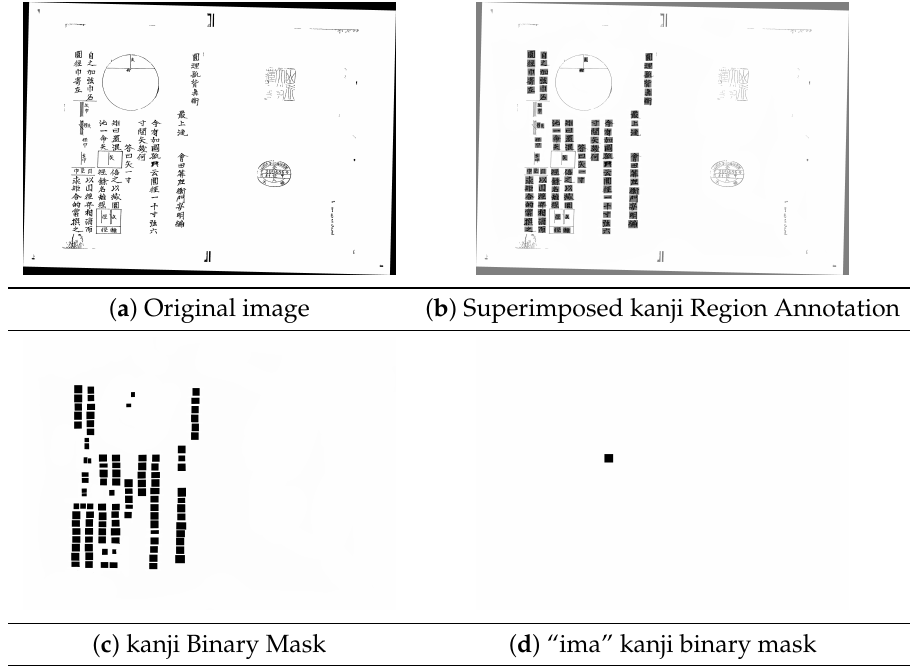
Figure 2. Data Annotation